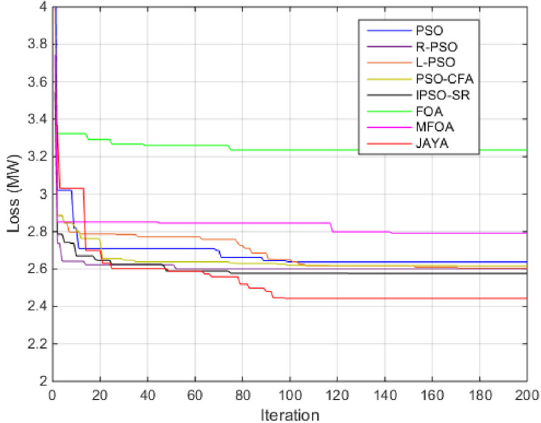
Fig. 10 Convergence characteristics of the algorithms for the IEEE 30 bus system with overestimated Weibull probability distribution function of wind power on ORPD